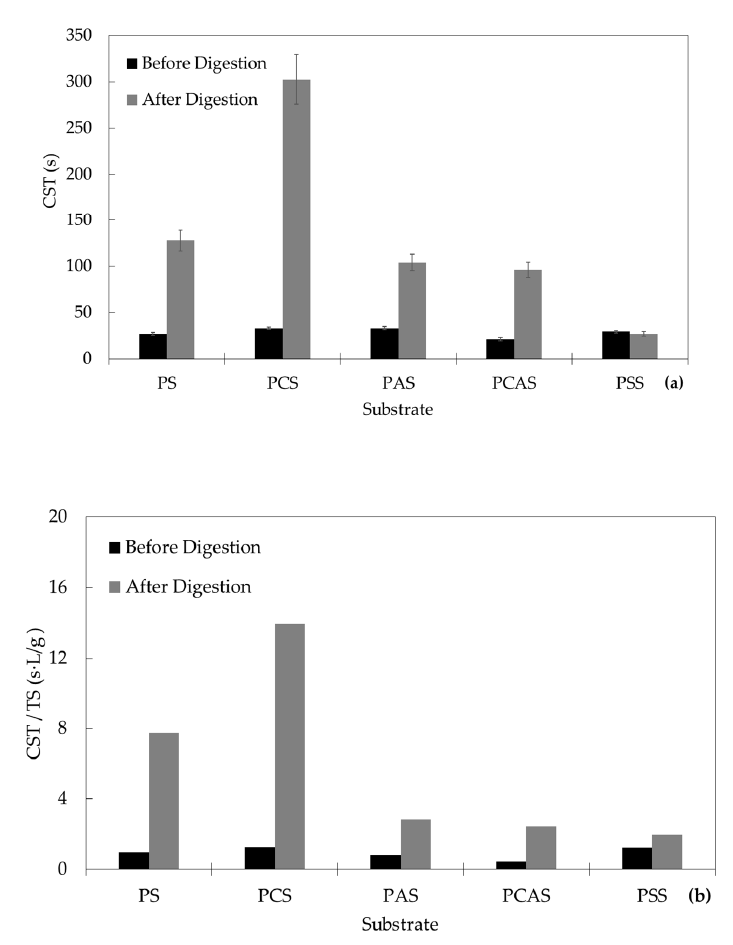
Figure 10. ( a ) CST at SIR = 1:1 g VS substrate/g VS IN for the substrates PS, PCS, PAS, PCAS, PSS, (error bars indicate standard deviation of mean values), ( b ) normalized CST for the substrates PS, PCS, PAS, PCAS, PSS.